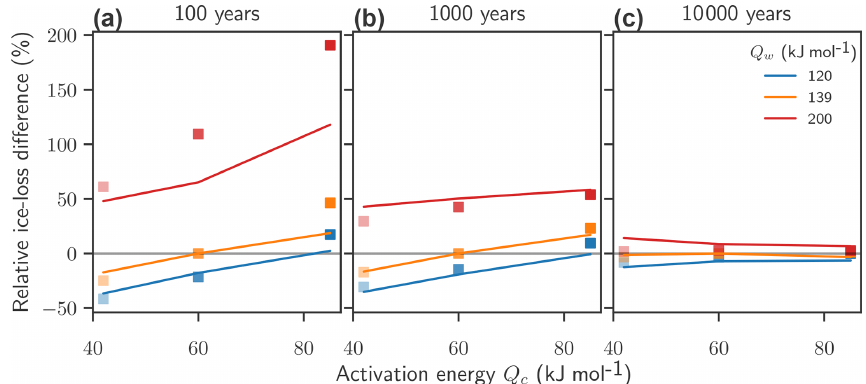
Figure 11. Effect of the flow exponent and activation energies on flow-driven ice loss under 2 ◦ C of ice warming in combination with a 50% reduction in accumulation rates: relative difference in flow-driven ice discharge after 100 (a) , 1000 (b) , and 10 000 (c) years. The ice sheet has reached a new equilibrium after 10 000 years. Relative difference for 2 ◦ C warming with an additional reduction of the accumulation rate of 50% (squares) is compared to the results without changes in the accumulation rate (lines; also see Fig. 7).